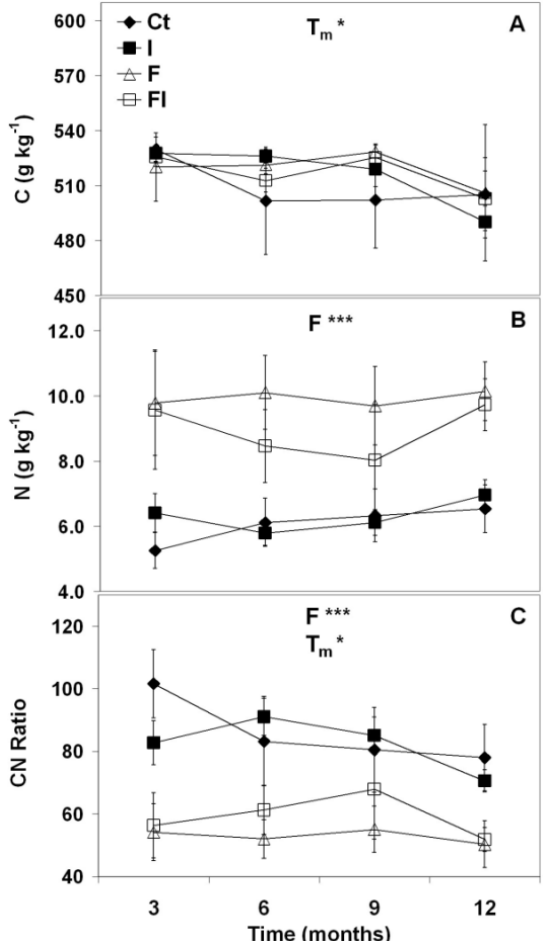
Figure 2. Mean litterbag C concentration ( A ), N concentration ( B ), and CN ratio ( C ) for forest floor Oi and Oe horizon material from May 2009 to May 2010 for the simulated forest floor decomposition experiment. Error bars represent 1 standard deviation. Main and interaction effects were significant at p < 0.05 ( * ), 0.001 ( ** ), and 0.0001 ( *** ). Effects: fertilization (F), irrigation (I), and time (T m